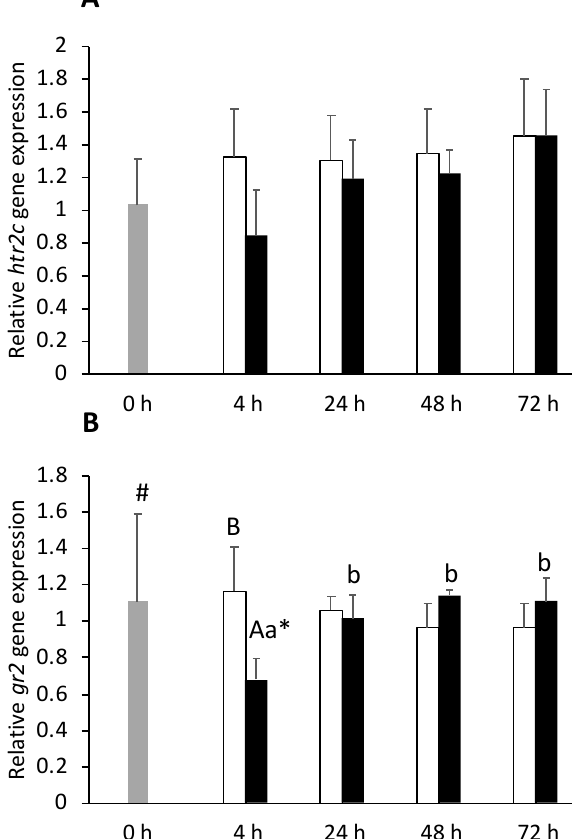
Figure 3. Optic tectum expression of serotonin receptor 2C ( htr2c , A ) and glucocorticoid receptor 2 ( gr2 , B ) in undisturbed European seabass (0 h, ) or i.p.-injected with a sham solution (CTRL, □ ) or Freund’s Incomplete Adjuvant (FIA, ■ ) and sampled at 4, 24, 48, 72 h post-injection (means ± SD, n = 8). Different symbols (* and #) stand for significant differences between i.p.-injected groups and the undisturbed group (0 h). Capital letters stand for significant differences between stimuli. Lower- case letters indicate significant differences between sampling times. Further details in legend of Figure 1.